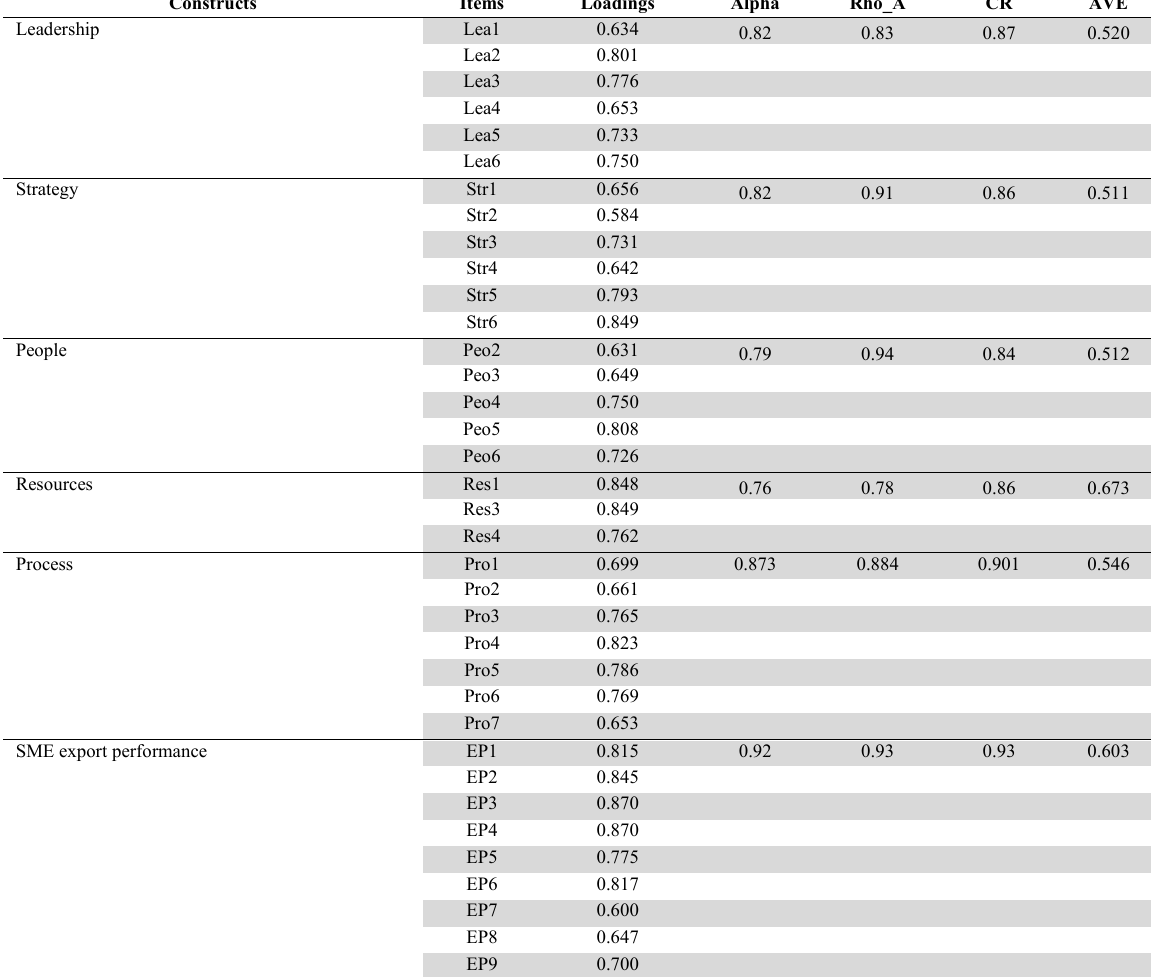
Fig. 2. PLS-SEM Algorithm (measurement model) AVE and Factors loading of items (1 st order) Finding of the measurement model (First Order, Reflective)